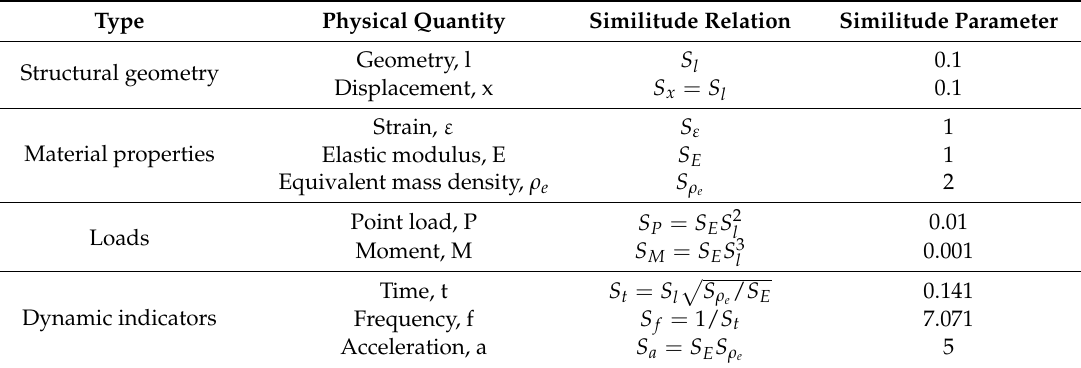
Table 1. Similarity ratio of the test.